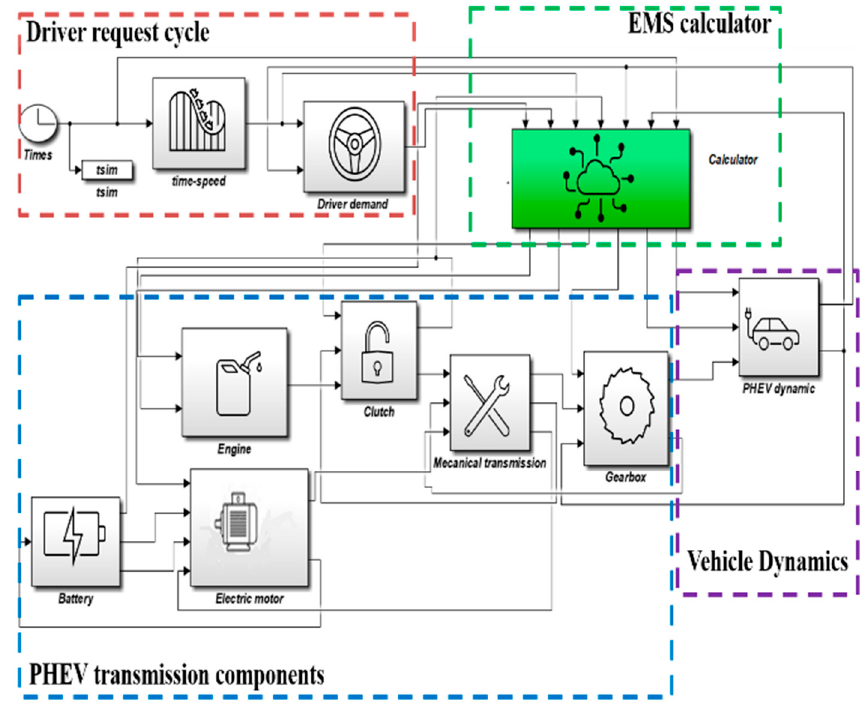
Figure 5. The global EMS-Parallel-PHEV model presenting four main sub-blocks.